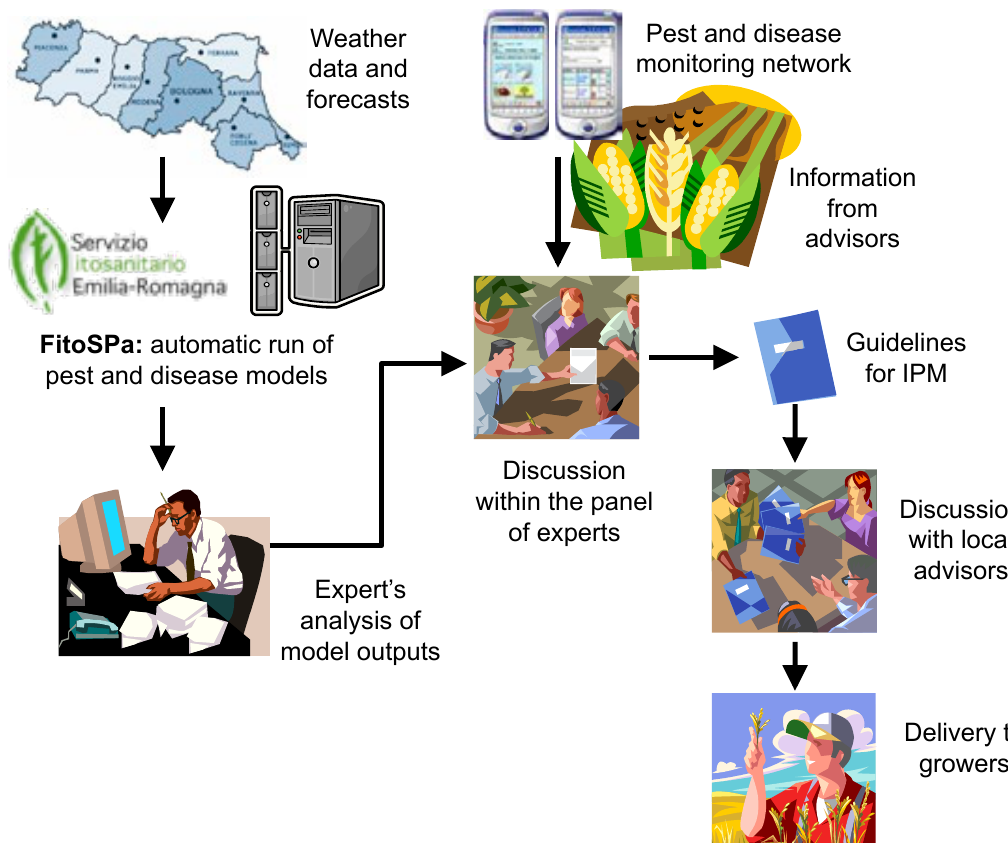
Figure 9. Organization and information flow in the warning service of the Emilia-Romagna (North Italy) provided by the regional plant protection organization (Servizio Fitosanitario). Weather data are used as input for pest and disease models on a daily basis; fields are monitored for pests, diseases, and other aspects of production at weekly intervals. Experts and advisors discuss the information, usually at weekly intervals, and provide guidelines and warnings to